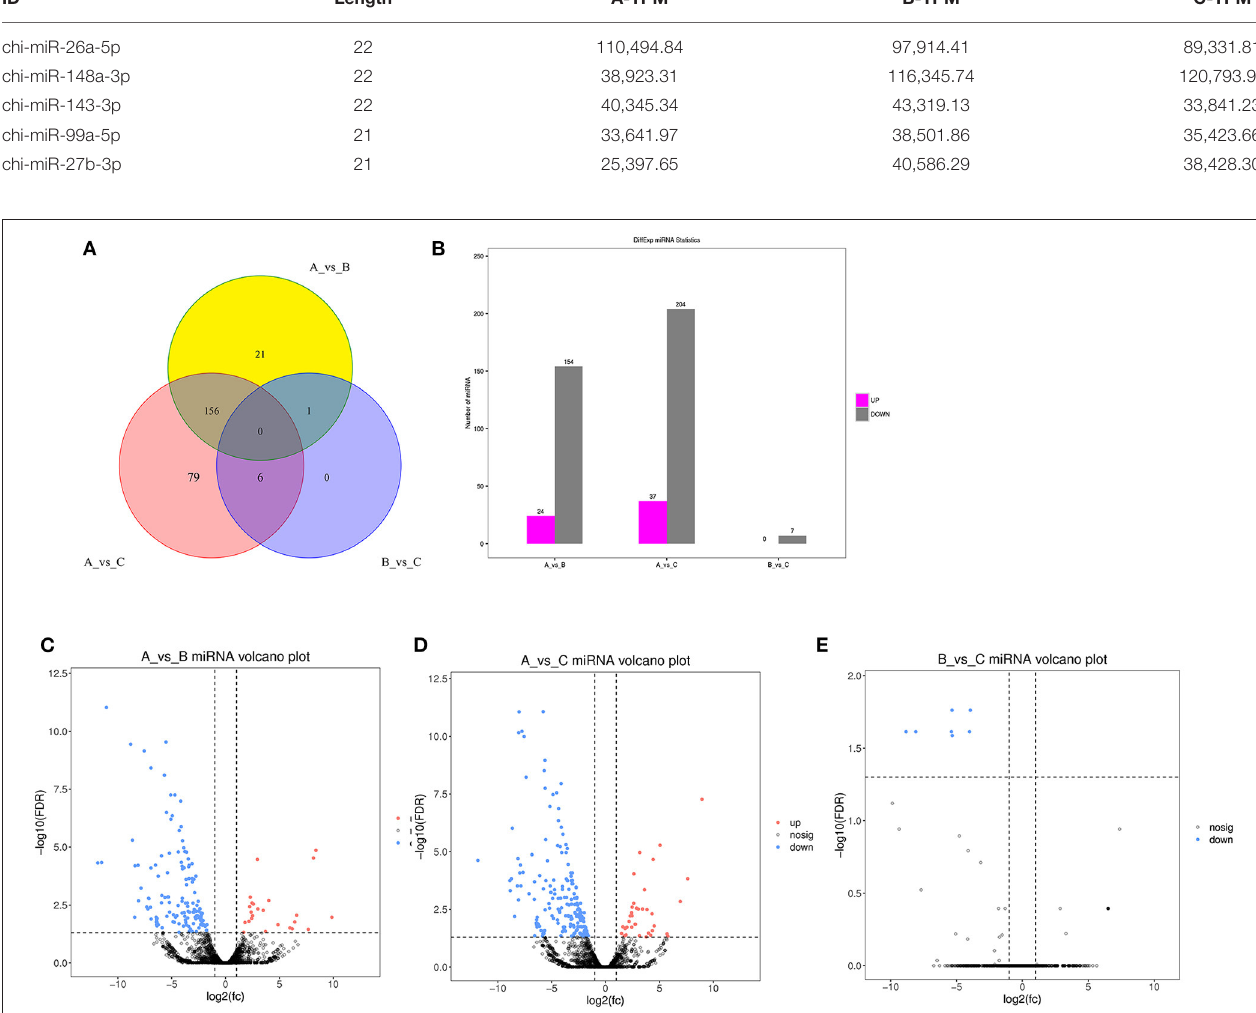
FIGURE 1 | Identification of DE miRNAs. (A) Venn diagram of DE miRNAs between three different age groups. A were the samples for goats of 1-month-old (group A), B were the samples for goats of 12-month-old (group B), C were the samples for goats of 24-month-old (group C). (B) histogram of miRNAs at three different age groups. (C) Volcano Plot of DE miRNAs between group A and B. (D) Volcano plot of DE miRNAs between group A and C. (E) Volcano plot of DE miRNAs between group B and